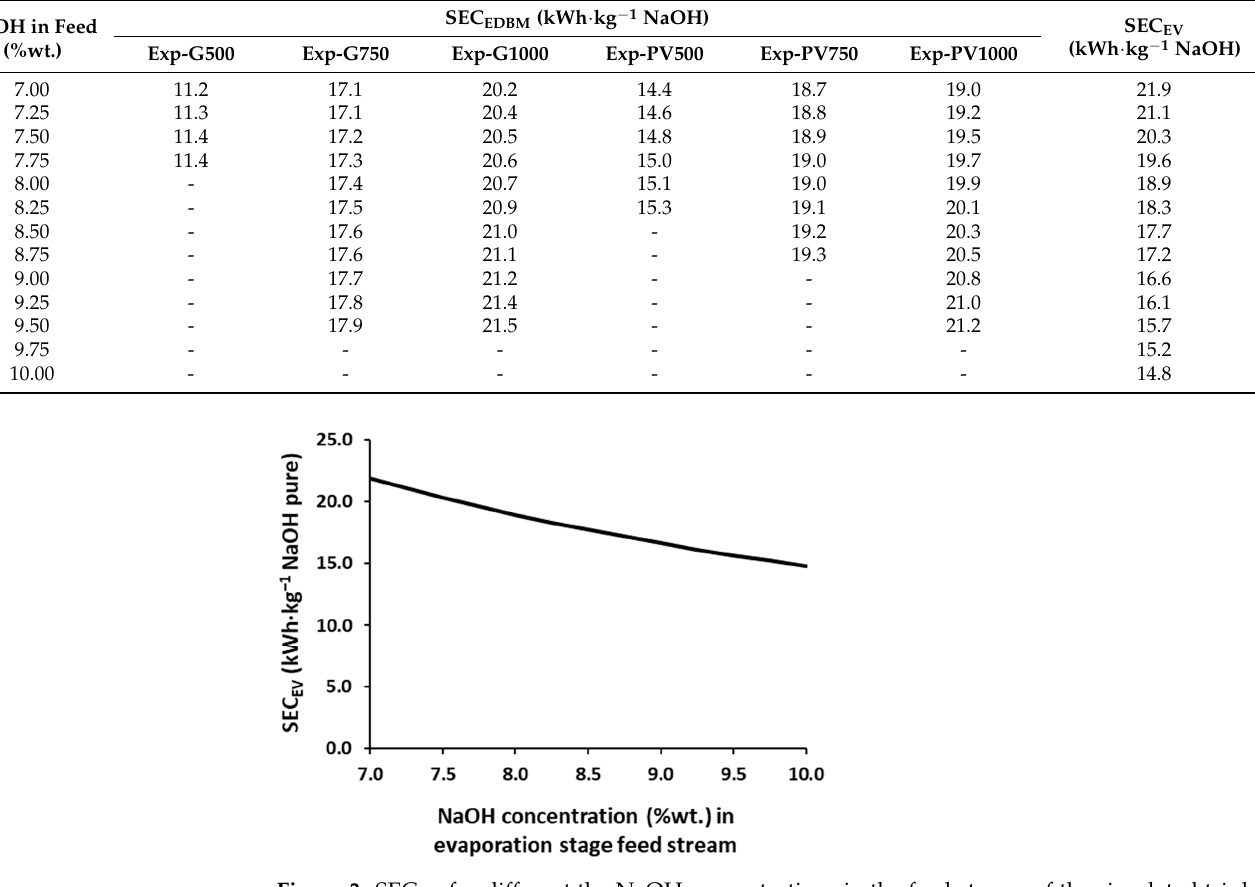
Figure 3. SEC EV for different the NaOH concentrations in the feed stream of the simulated triple effect evaporation.